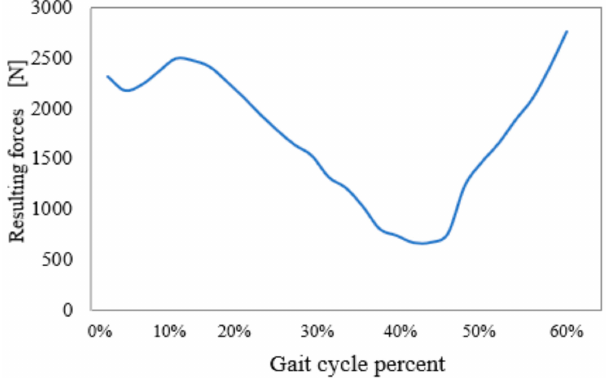
Figure 17. Resulting forces on the tibiofemoral joint in a gait cycle during the support